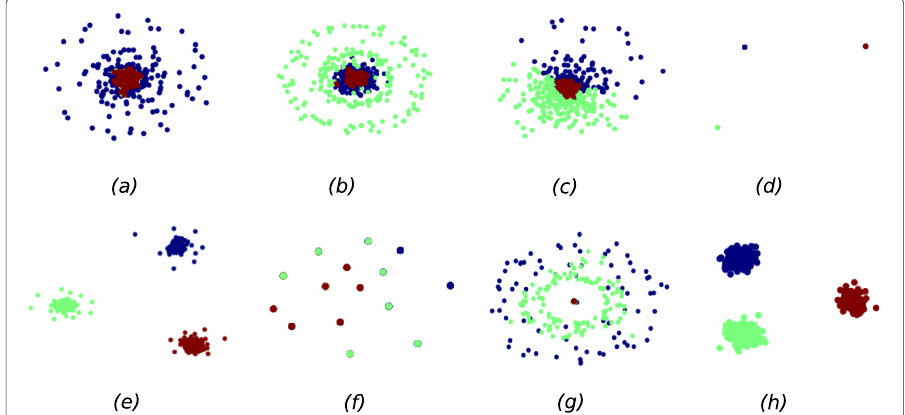
Fig. 3 Visualization of permuted Erd˝os-Rényi (ER) dataset. Each point corresponds to a network. Color of a point indicates the category of the network according with its average degree (cid:11) d (cid:12) . For blue (cid:11) d (cid:12) = 4, green (cid:11) d (cid:12) = 6 and red color (cid:11) d (cid:12) = 8 a Jaccard. b Hamming. c Deltacon. d Claplacian. e Graph2vec. f GAM. g Subgraph2vec. h